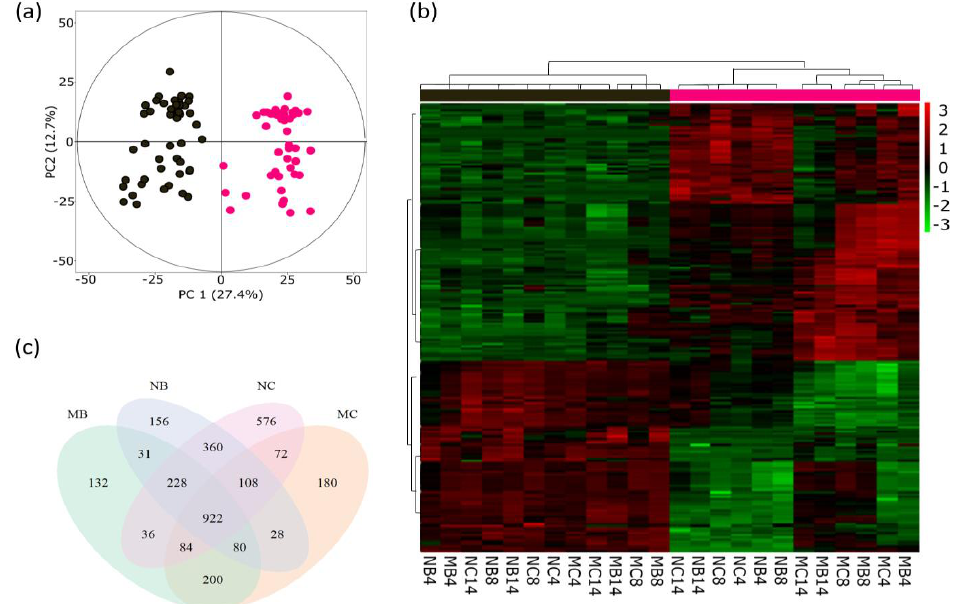
Figure 1. Principal component analysis (PCA) ( a ), hierarchical clustering analysis (HCA) ( b ) and Venn diagram ( c ) show the metabolomic differences for old, not directly infested ( • ) and young, Chrysomela populi -infested ( • ) leaves of mycorrhized and non-mycorrhized poplar trees. ( a ) PCA separates infested leaves (leaf #5 from apex) and old (non-infested) leaves (leaf #12 from apex). ( b ) HCA of LC-MS intensities of 200 most significant discriminant mass features on the days 4, 8 and 14 after the release of herbivores. ( c ) Venn-diagram of discriminant mass features responsible for the separation of young/infested and old/non-infested leaves. NC = non-mycorrhizal poplars not exposed to leaf beetles, MC = mycorrhizal poplars not exposed to leaf beetles, NB = non-mycorrhizal poplars exposed to leaf beetles and MB = mycorrhizal poplars exposed to leaf